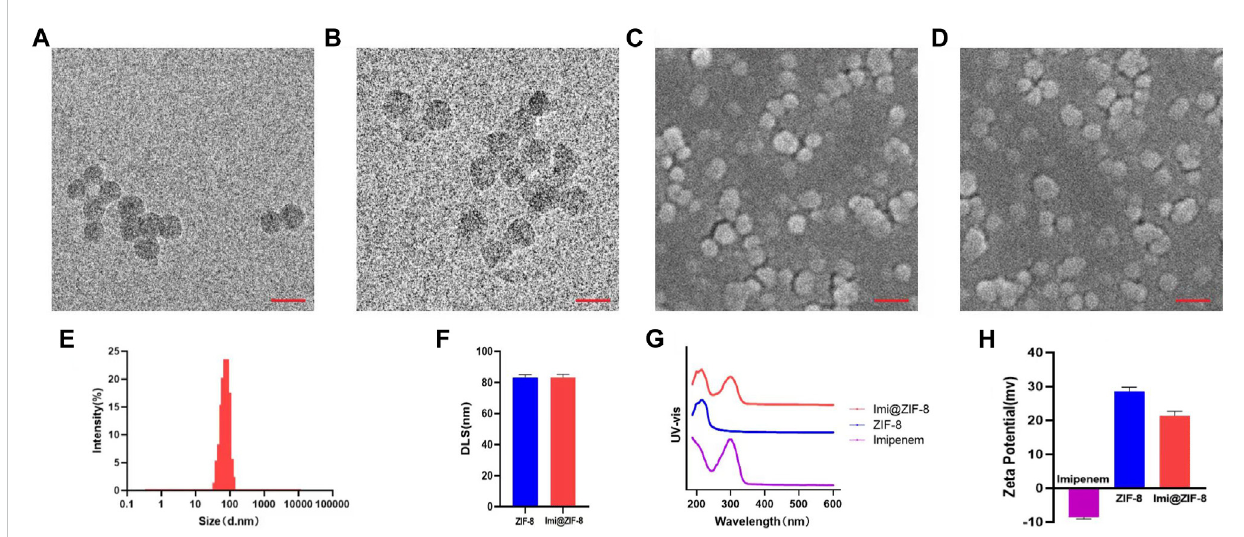
FIGURE 1 Characterization of ZIF-8 and Imi@ZIF-8. (A) TEMimageof ZIF-8. (B) TEMimageof Imi@ZIF-8. Scale bar is 150 nm. (C) SEM image of ZIF-8. (D) SEM image of Imi@ZIF-8. Scale bar is 200 nm. (E) Particle sizes of Imi@ZIF-8 detected byTEM. (F) Dynamic light scattering (DLS) analyze the hydrated particle size of ZIF-8 and Imi@ZIF-8. (G) UV-vis spectrometries of imipenem, ZIF-8 and Imi@ZIF-8. (H) Zeta Potential values of imipenem, ZIF-8 and Imi@ZIF-8. Data are presented as means ± SD ( n =